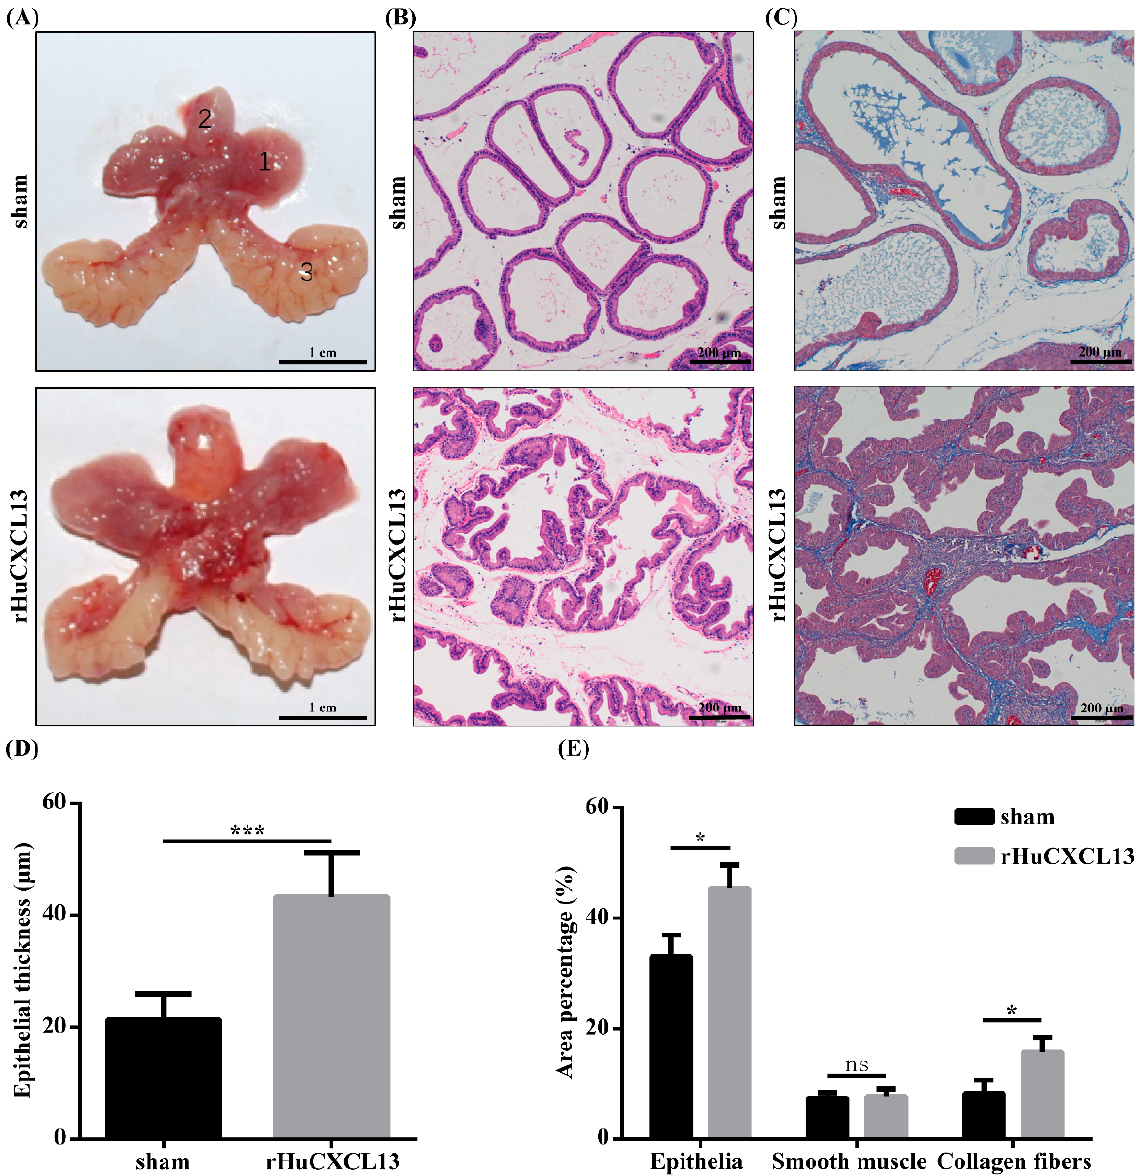
Figure 7. rHuCXCL13 induces the development of BPH in vivo. ( A ) The rat urogenital tissues from sham and rHuCXCL13-treated rats. (1) Ventral prostate, (2) bladder and (3) seminal vesicle. ( B ) Representative H&E staining of sham and rHuCXCL13-treated rat prostates. ( C ) Masson’s trichrome staining of sham and rHuCXCL13-treated rat prostates. Prostate epithelial cells were stained orange, SM cells were stained red, and collagen fibers were stained blue. ( D ) Statistical analysis of epithelial thickness of sham and rHuCXCL13-treated rat prostates. ( E ) Quantification of Masson’s trichrome staining. The scale bars are 200 μ m. * p < 0.05, *** p < 0.001 and ns means no significant difference. Table 1. Variation of biometric and physiological parameters in sham and rHuCXCL13-treated rats. Body Weight (g) Ventral Prostate Group Weight